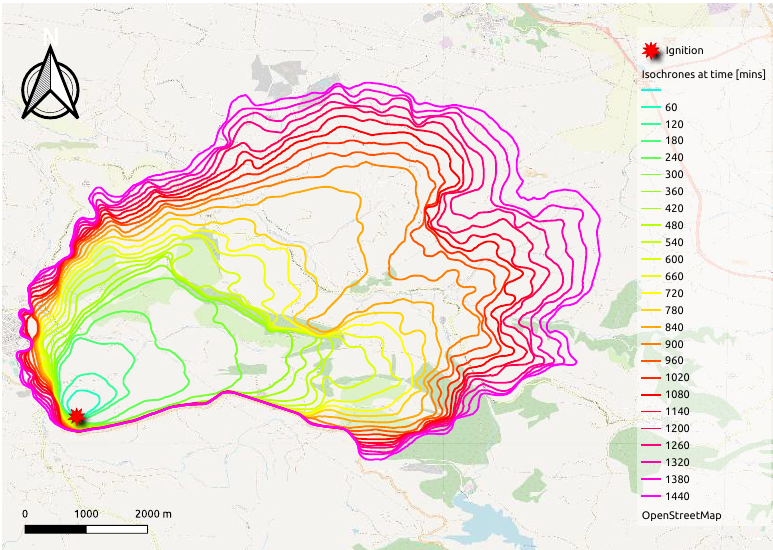
Figure 13. Time history of the simulation of Ittiri wildfire. The colored lines represent the isochrones that identify the simulated burnt areas with probability higher than 50% that are produced at each time step (one hour) until the end of the simulation (24